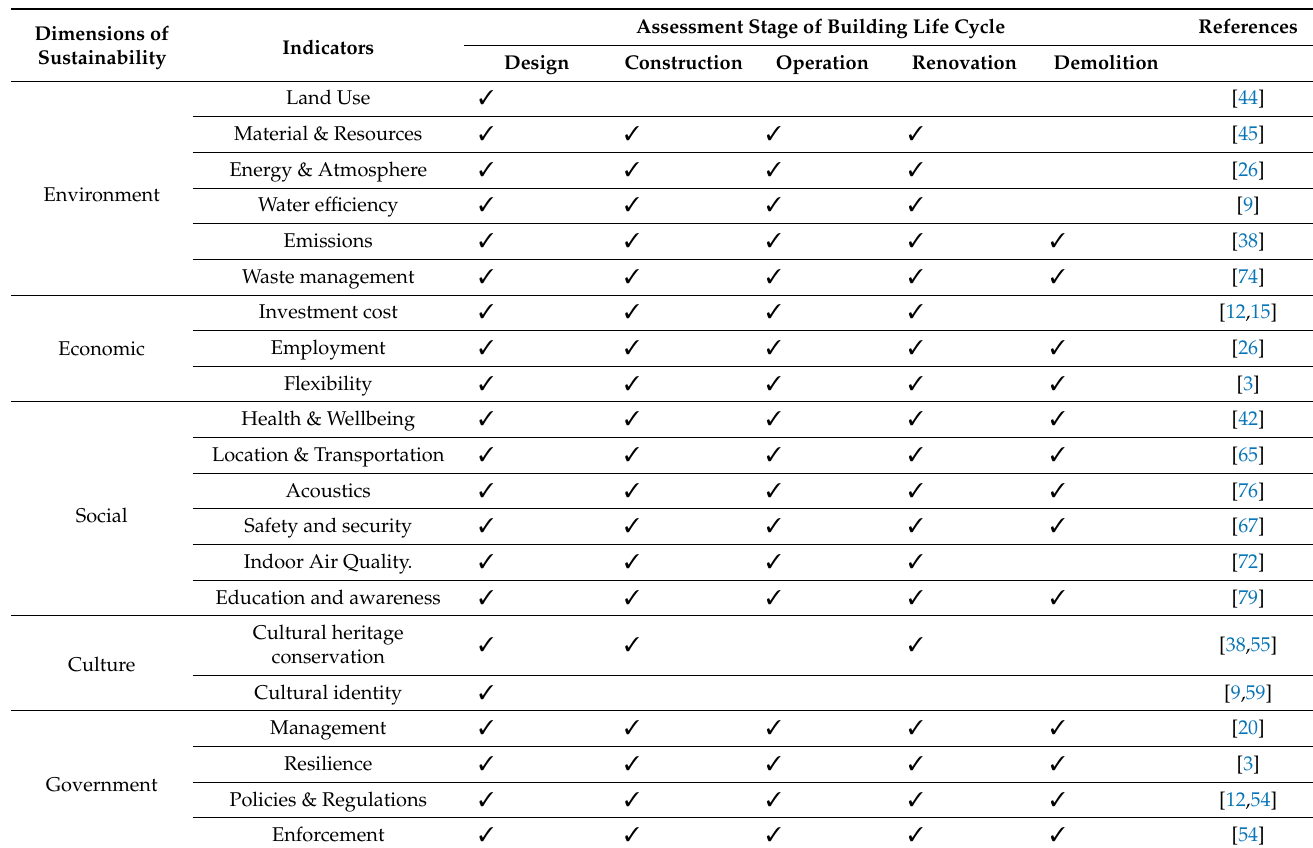
Table 6. Proposed conceptual